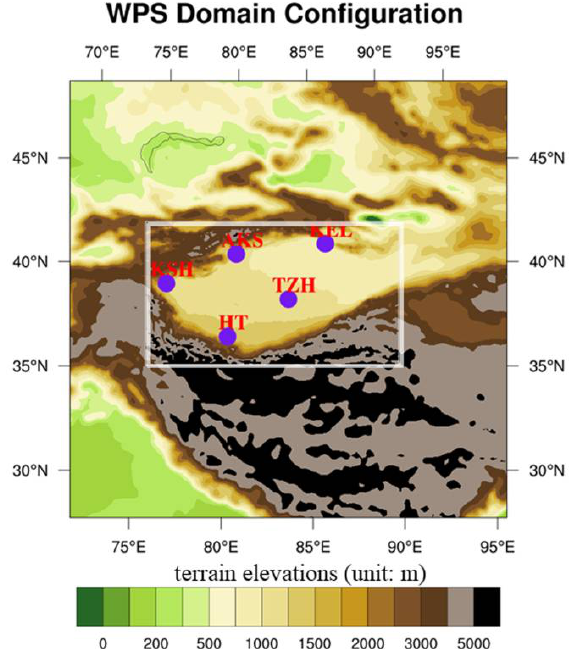
Figure 2. Nesting domain 1 (i.e., whole area) and domain 2 (i.e., region within the black rectangular), with the locations of five monitoring stations in the Tarim Basin (TB). Colored contours indicate terrain elevation in m a.s.l. Table 1. Physical parameters and variables utilized in WRF-Chem.